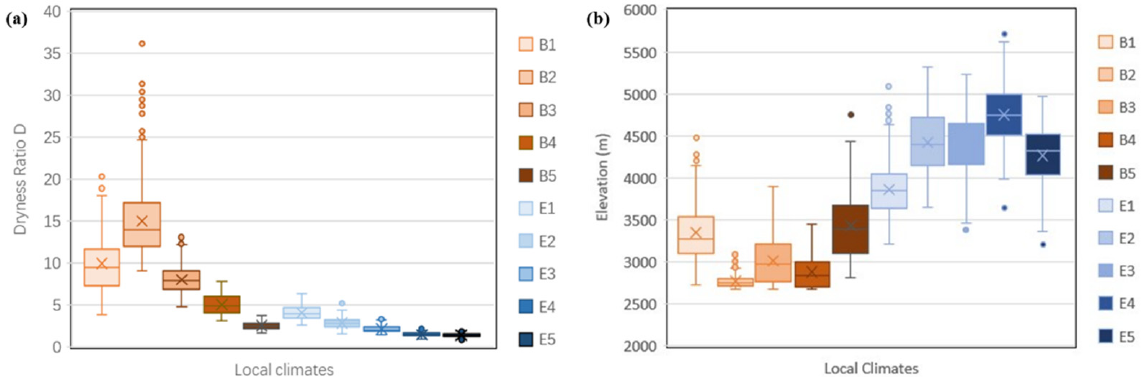
Figure 8. The distributions of ( a ) dryness ratios and ( b ) altitudes associated with the fine-grained climate classification.